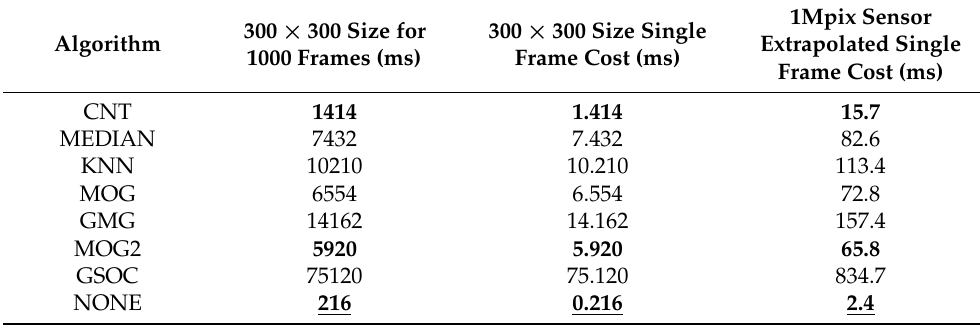
Table 3. Mean values for computational time. The three best results are marked, and the highest value is underlined. Calculated for default parameter